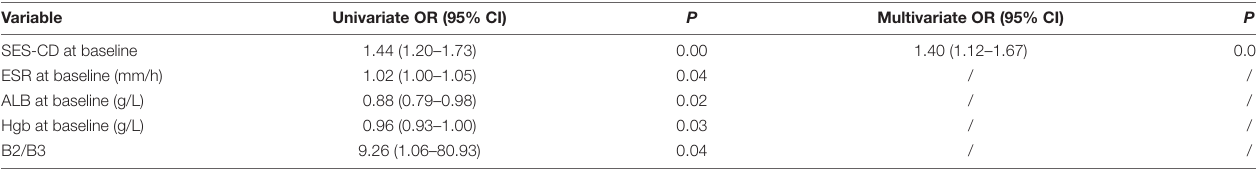
TABLE 2 | Predictive variables of MH at the end of